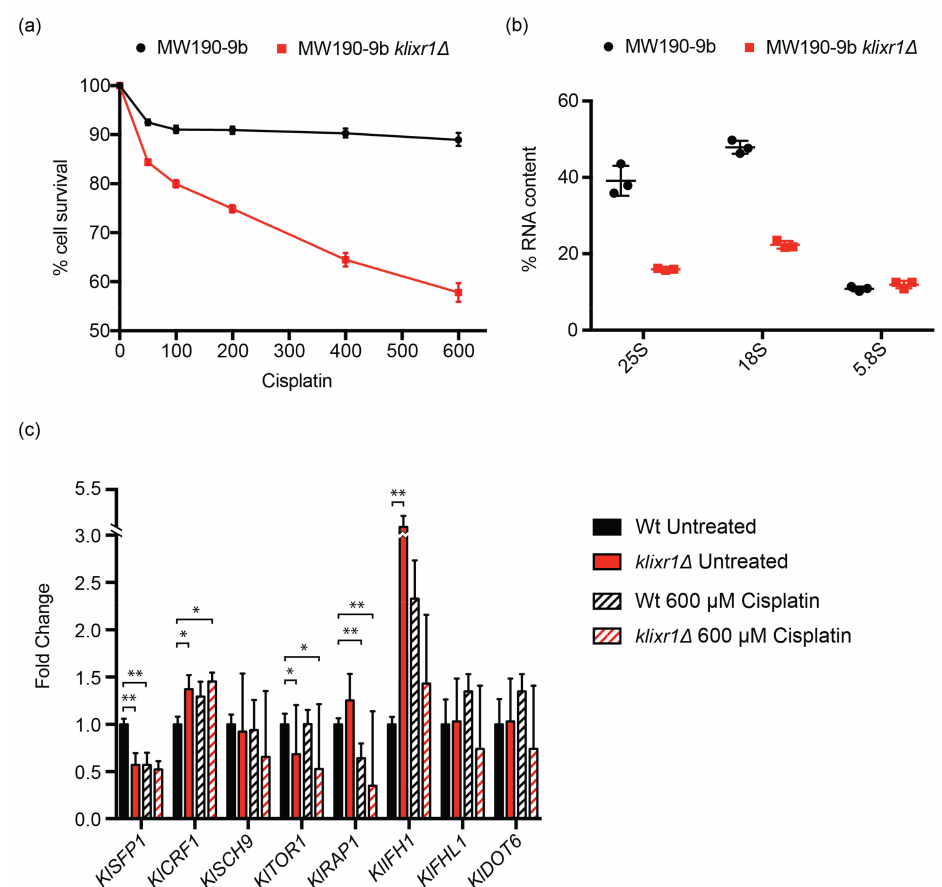
Figure 3. Study of the cellular response of MW190-9b strain (black) and its derivative ixr1 ∆ (red) to cisplatin treatment. ( a ) Resistance to cisplatin in the wild type and klixr1 ∆ null strains. Cells from the K. lactis strain MW190-9B and its isogenic derivative MW190-9B- ixr1 ∆ were treated with several concentrations of cisplatin (0, 50, 100, 200, 400, and 600 µ M). After 24 h of growth at 30 ◦ C, optical density measurements at 600 nm were taken, and survival rates were calculated by normalization from untreated cultures. ( b ) rRNA cellular content determination by microfluidic-based automated electrophoresis. ( c ) mRNA levels of KlSFP1 , KlCRF1 , KlSCH9 , KlTOR1 , KlRAP1 , KlIFH1 , KlFHL1, and KlDOT6 were analyzed by RT-qPCR, before (solid) and after (streaked) the treatment with 600 µ M of the chemotherapeutic agent cisplatin. Housekeeping gene KlTAF10 was used for gene normalization. * p < 0.05; ** p <